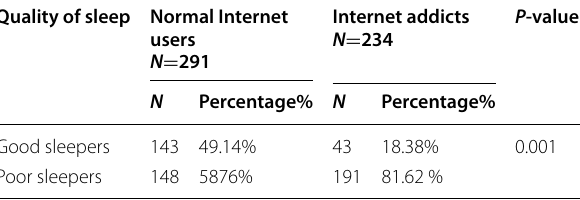
Table 3 Association between PSQI and Internet addiction Quality of sleep Normal Internet users